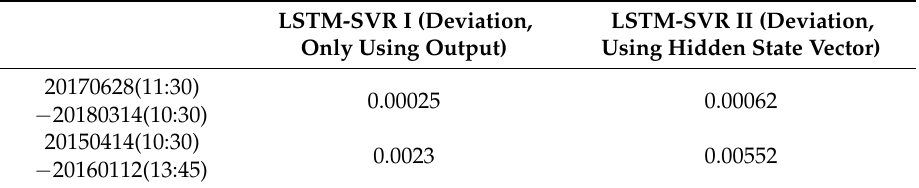
Table 6. Comparison table of the deviation values predicted by the LSTM-SVR I and LSTM-SVR II models (different input vectors) over two time